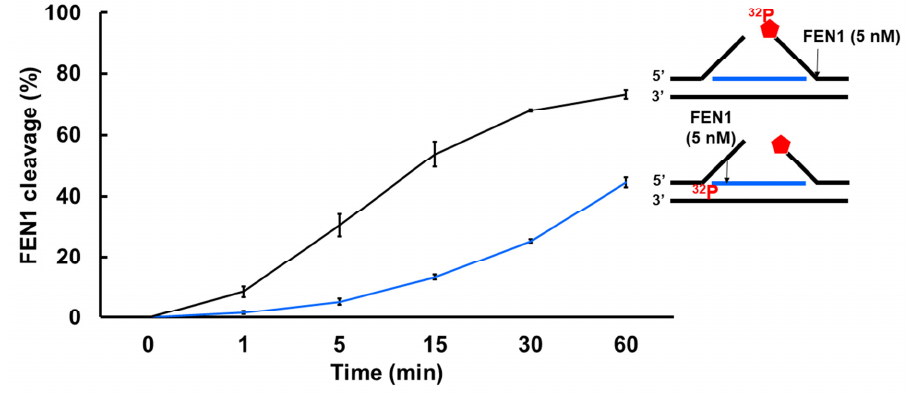
Figure 6. FEN1 cleavage on the DNA flap and RNA in an R-loop intermediate at different time intervals. The efficiency of FEN1 cleavage on the DNA flap and RNA in an R-loop intermediate was examined by determining the activity of FEN1 (5 nM) on the double-flap substrate (25 nM) containing a RNA:DNA hybrid at different time intervals (0–60 min). FEN1 cleavage on the 5 (cid:48) -DNA flap was measured using the substrate that was 32 P-labeled at the 5’-end of the downstream DNA flap. The percentage of FEN1 DNA flap cleavage products was plotted against different time intervals (line in black). FEN1 cleavage activity on the RNA strand in the R-loop substrate was measured using the substrate labeled with 32 P at the 5 (cid:48) -end of the RNA. The percentage of FEN1 RNA cleavage products in different time intervals was plotted (line in blue). All experiments were performed in triplicate. 3.4. APE1 3 ′ -5 ′ Exonuclease Cleaves RNA in an R-Loop during BER As one of the key BER enzymes, APE1 can incise the 5 ′ -end of an abasic site using its endonucleolytic cleavage activity, creating a 1 nt-gap as the substrate for pol β [40]. APE1 also possesses its 3 ′ -5 ′ exonuclease activity [40] that can remove a mismatched nucleotide at the 3 ′ -end of the upstream strand of a one-nucleotide gap [41]. Furthermore, it is shown that APE1 can also make endo- and exonucleolytic cleavage on RNA to exhibit its ribonu- clease activity [42–44]. We reason that APE1 exoribonuclease may also cleave the RNA strand in an R-loop during BER. To test this, we examined the APE1 cleavage activity on the RNA strand of the double-flap substrate with the 36 nt-RNA and the substrate con- taining the RNA strand with a 3 ′ -flap alone (Figure 7). We found that APE1 at 50 nM only removed one ribonucleotide from the 3 ′ -end of the RNA strand on the double-flap sub- strate with low efficiency (Figure 7A, lane 5). APE1 lower than 50 nM failed to cleave the